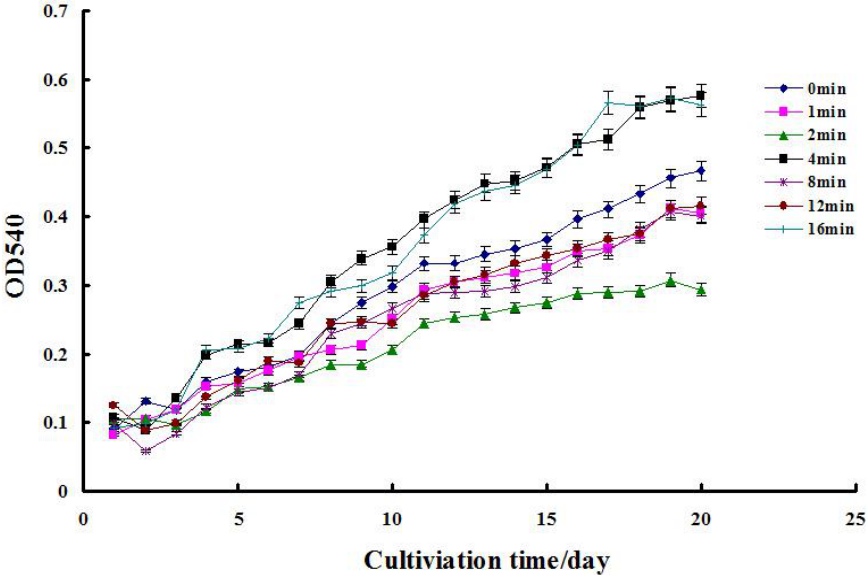
Figure 2. Microalgal cell growth curves after irradiated by Nd: YAG Laser with different time.